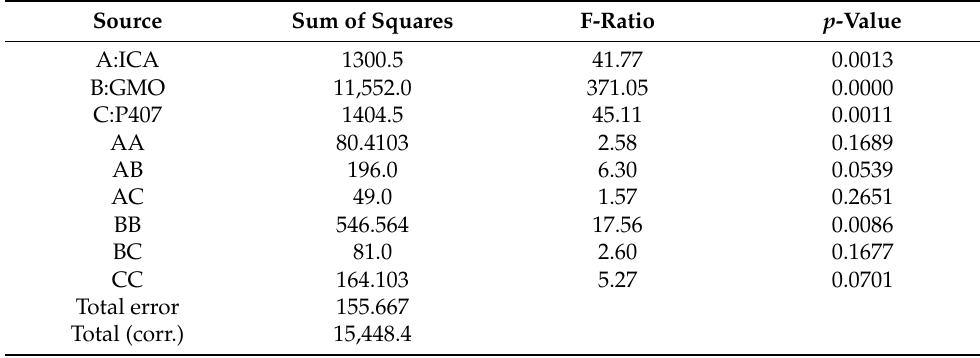
Table 2. Analysis of variance data for particle